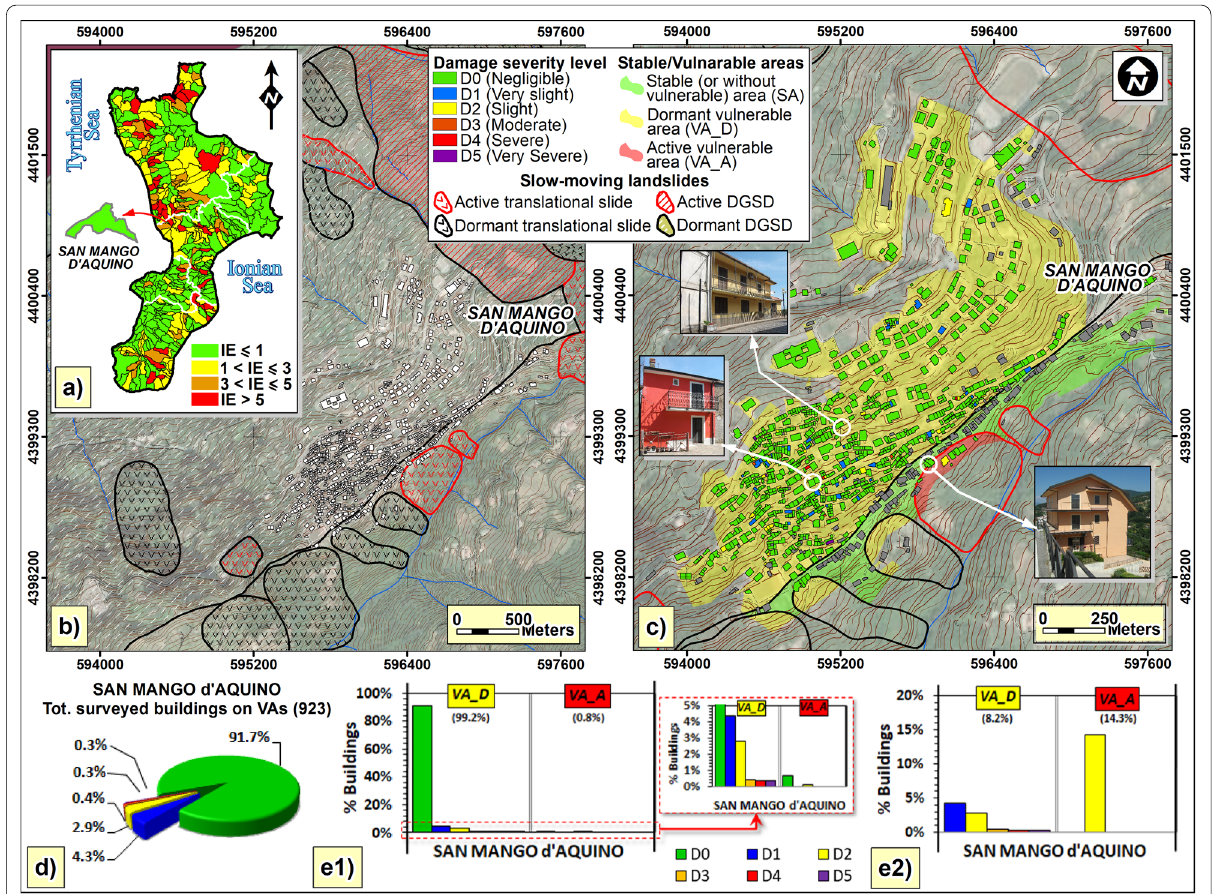
Fig. 16 Maps of San Mango d’Aquino municipality exhibiting a low value of the Index of Exposure (IE municipalities (zoning units) distinguished according to the IE values; b slow-moving landslide (SML) inventory map; c map of the Urban Areas (UA) overlapped to the identified stable (or without vulnerable) areas (SAs) and vulnerable (VAs)—distinguished in “ active ” (VA_A) or “ dormant ” (VA_D) areas—with buildings classified according to the recorded damage severity level and some photos of buildings taken during in-situ surveys. The percentages of the recorded buildings damage severity levels located over the identified VA are shown in d) jointly with their distribution based on e1) the total UA (divided in SA, VA_D and VA_A) and e2) the single (SA, VA_D and VA_A)